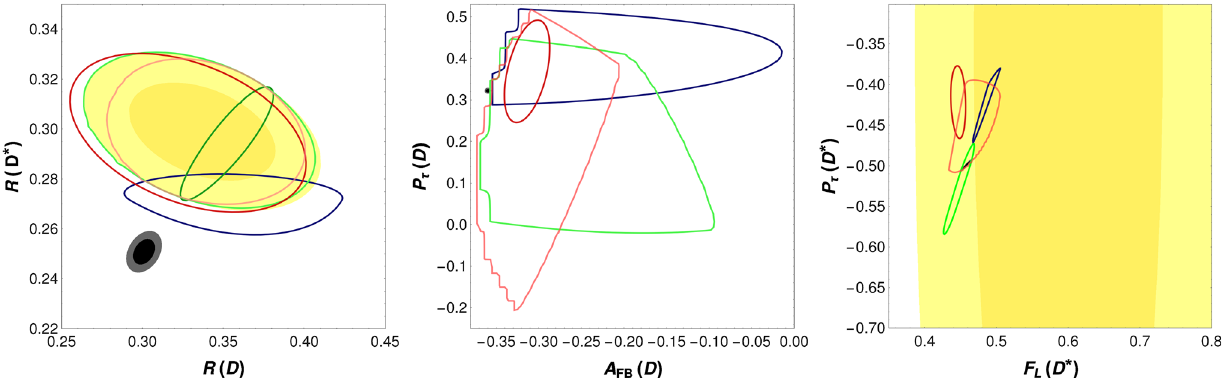
Fig. 2 State-of-the-artfitresultsinsingle-mediatormodelsforselected pairs of observables in B → D ( ∗ ) τν decays (following Ref. [114] for form factor and input treatment). All outer ellipses correspond to 95% confidencelevel,inner(wherepresent)to68%.WeshowtheSMpredic- tion in grey, the experimental measurement/average in yellow (where applicable) and scenarios I, II, III IV and V in dark green, green, dark